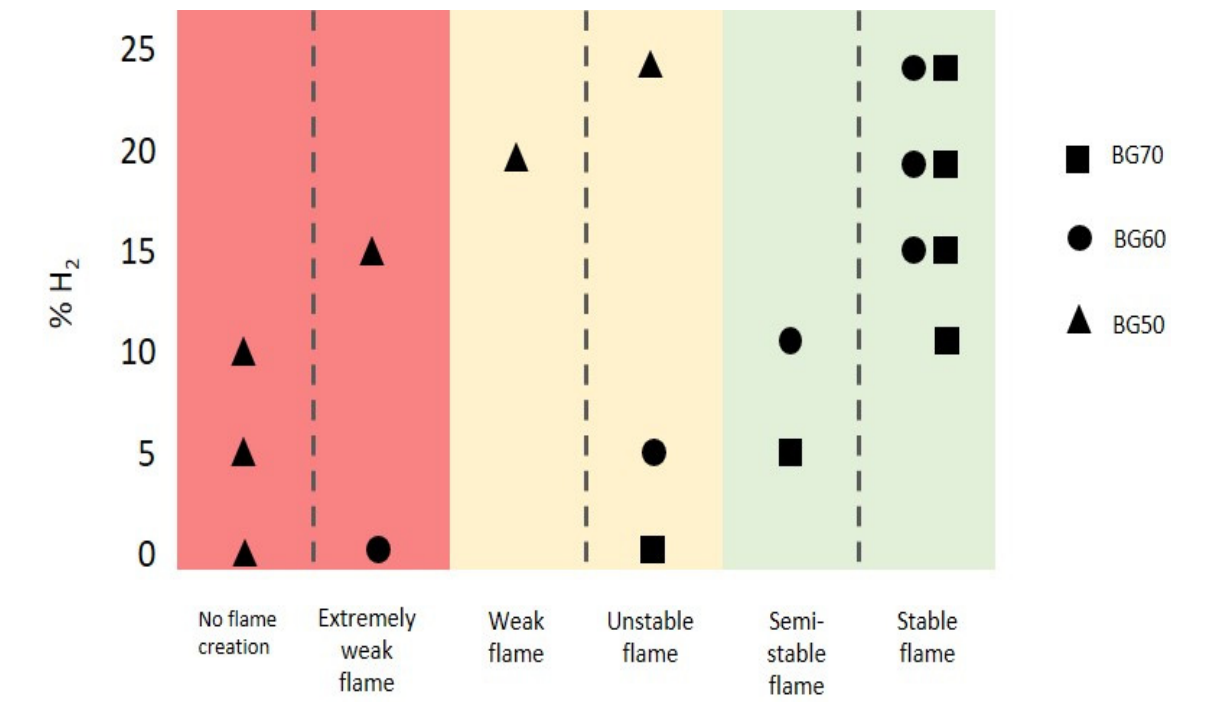
Figure 10. Stability map.